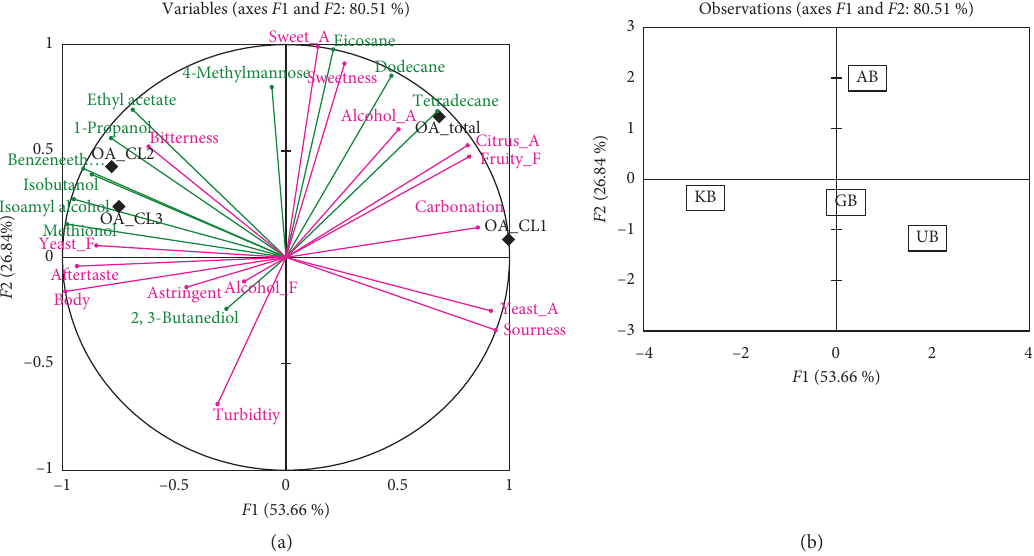
Figure 6: (a) Correlation map of volatile compounds (green), sensory attributes by 102 consumers (magenta; A: aroma, F: flavour), and overall acceptance (OA) of each consumer group by preference (cluster 1, 2, and 3; CL 1, 2, and 3) and total consumers (diamond). (b) Four wheat beer samples by first two dimension of multiple factor analysis. GB, UB, KB, and AB represent wheat beers made of grist containing 50% of wheat malt from German, USA, and Korean wheat variety ( Keumkang and Anzunbaengi ), respectively.